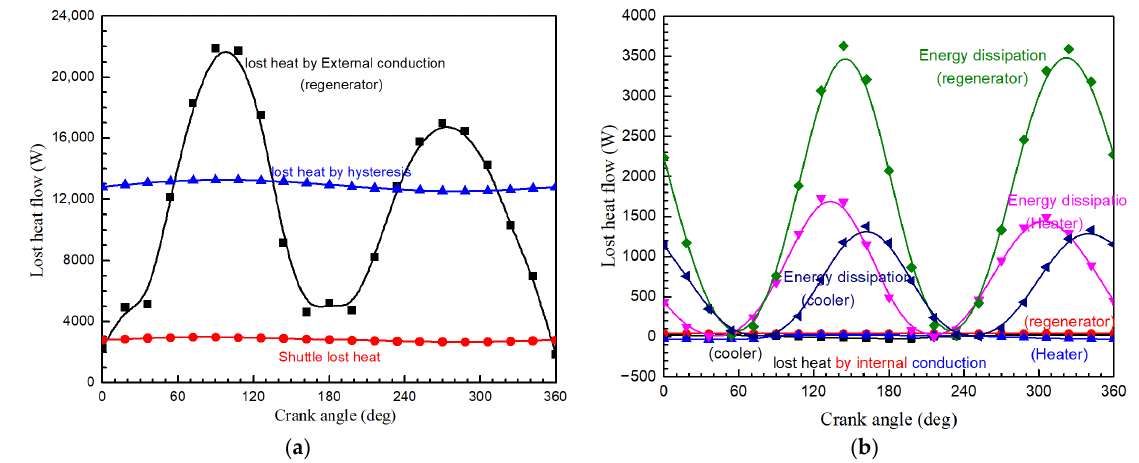
Figure 10. Heat loss of CTPC: ( a ) Lost heat flow by hysteresis, shuttle, and regenerator, ( b ) internal conduction heat lost and energy dissipation in the CTPC. The transient current and voltage, as well as the electric power of the CTPC alter- nator, are shown in Figure 11. The corresponding average electric power output of the CTPC is 17.316 kW and the average heat absorbed by the heater is 66.1 kW, which leads to a converter efficiency of 26.2%. The average current and voltage of the CTPC alterna- tor are 86.38 A and 193.15 V, respectively.